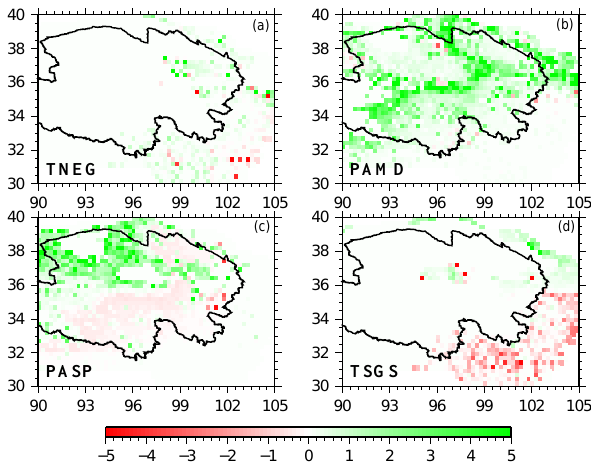
Figure 11. Elasticity of individual FPCs with 10% CO 2 increase. Table 6. The responses of the FPCs of individual PFTs to CO 2 in- crease. Cells of positive Cells of negative response response FPC of TNEG 367